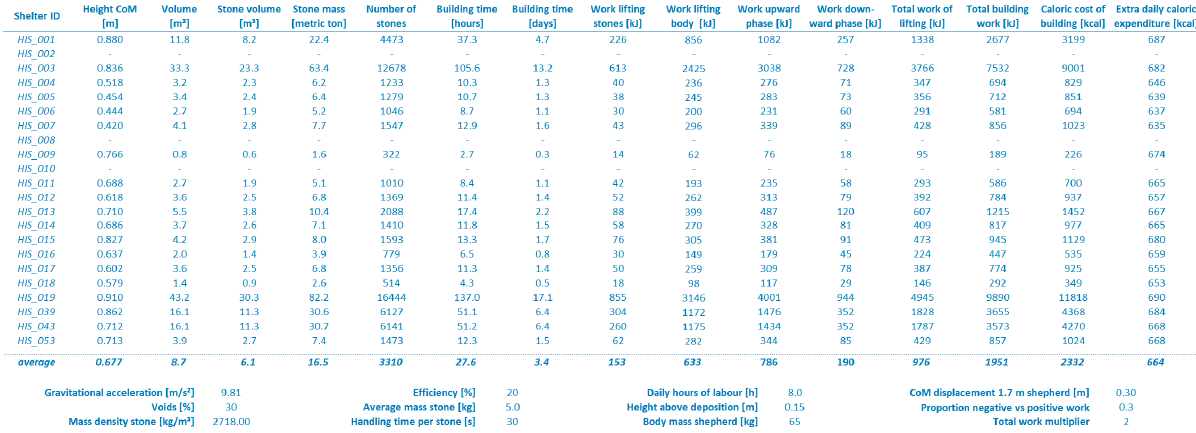
Figure 6. This figure tabulates all the shelter-specific derived data and provides the values of the variables used in the